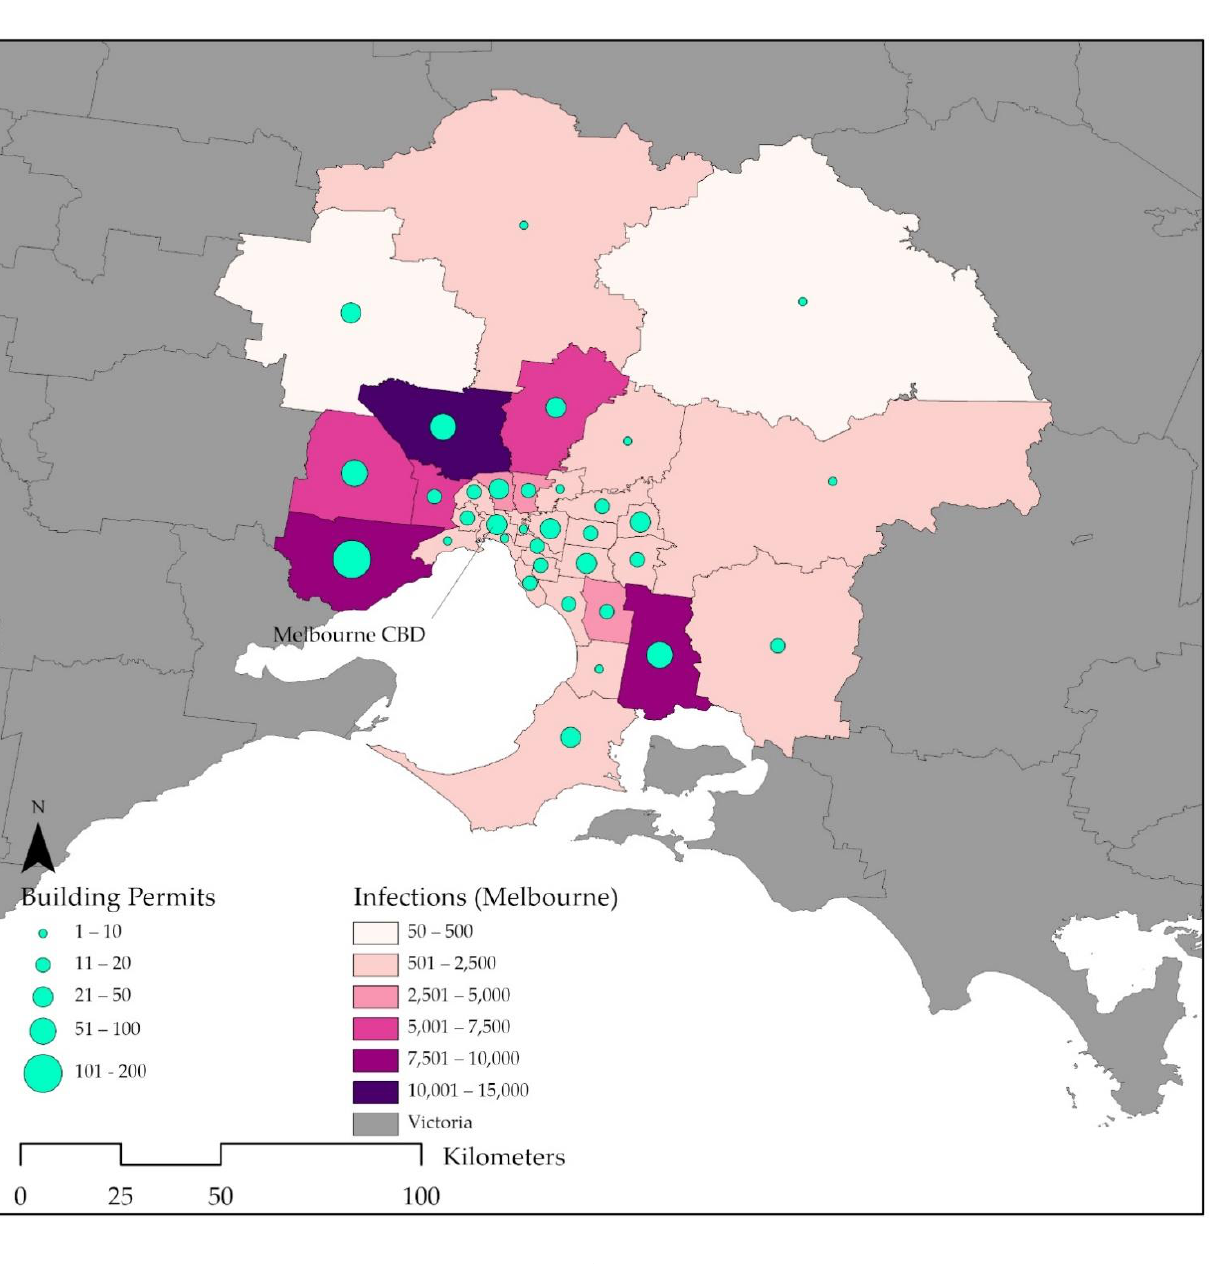
Figure 13. Choropleth maps showing COVID-19 cases overlayed by graded symbology showing the number of approved construction sites across ( a ) Sydney and ( b ) Melbourne.